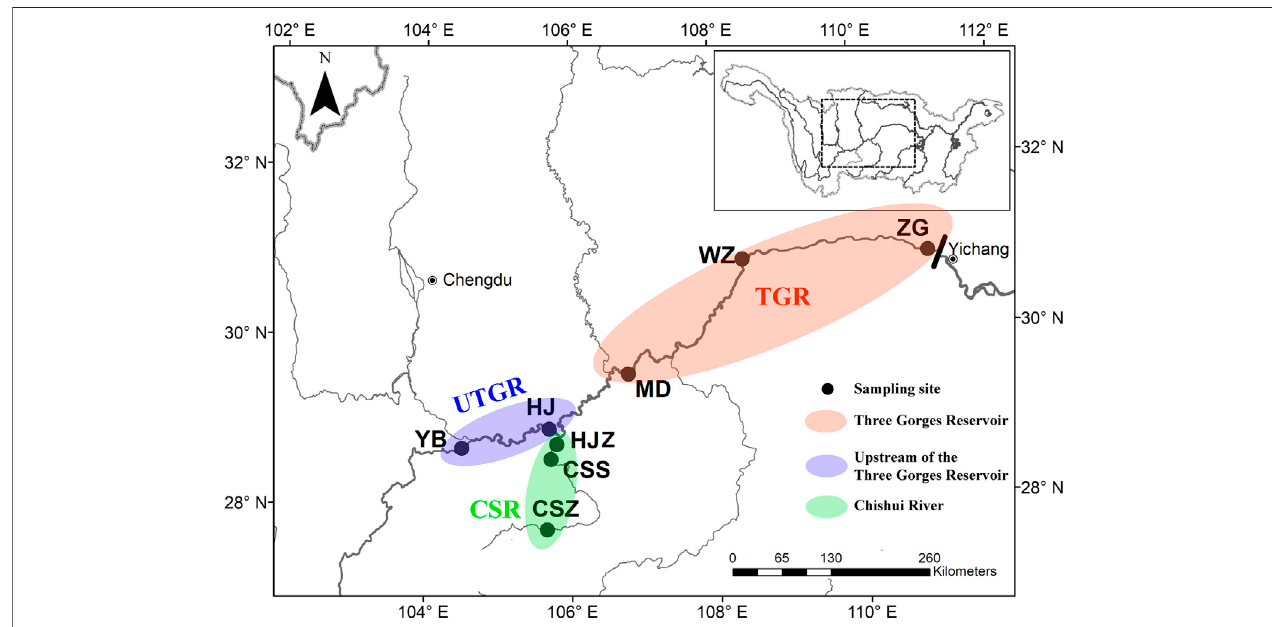
FIGURE1| Studyareaandsamplingsitesupstream oftheThreeGorgesDam.TheredellipseindicatestheThreeGorgesReservoirarea;theblue ellipseindicates the upper reaches of the Three Gorges Reservoir; and the green ellipse indicates the Chishui River.